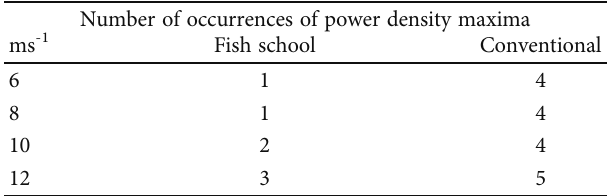
Table 5: Number of occurrences of power density